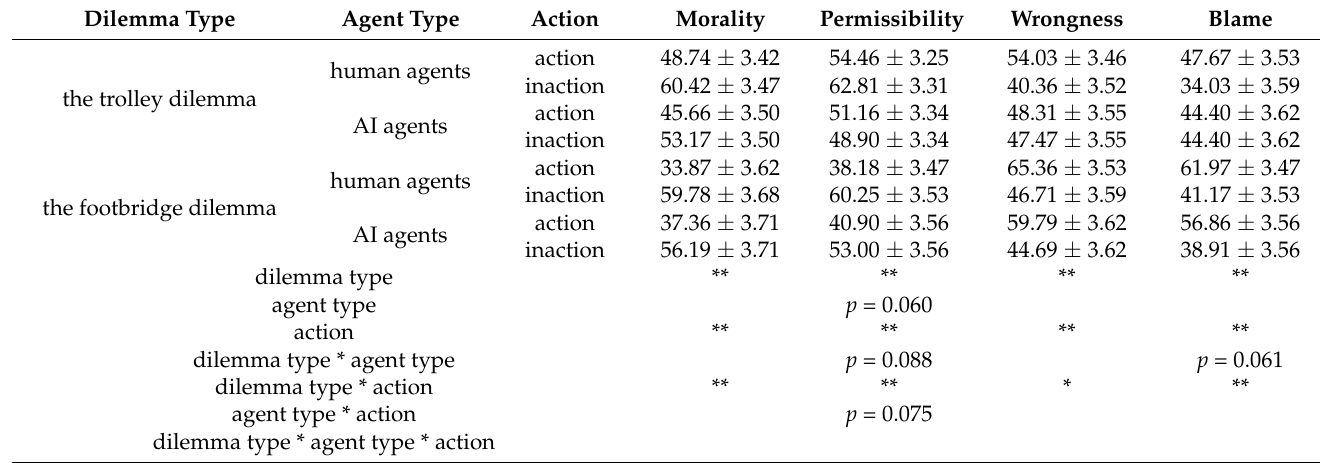
Table 3. Rates of morality, permissibility, wrongness, and blame on human and AI agents in Experiment